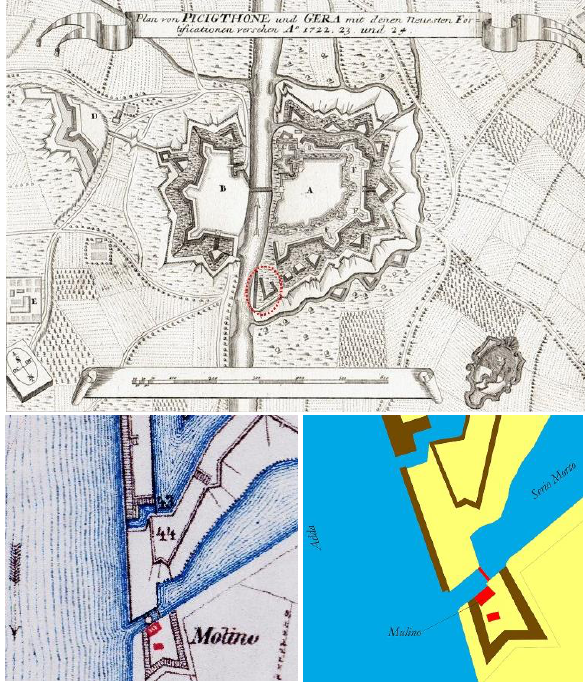
Figure 5. Above: the ruins of the watermill, details of the mill structure unearthed during the archaeological excavation.